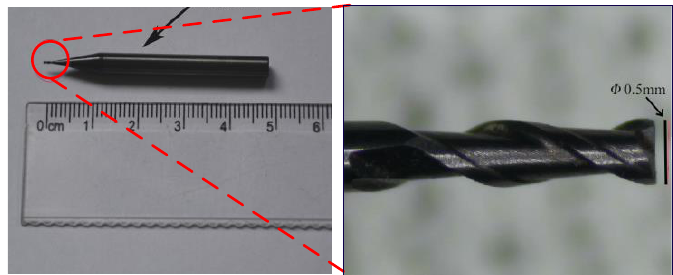
Figure 22. Structure of micro-milling tool. Table 5. Parameters of the micro-milling tool used in the test.